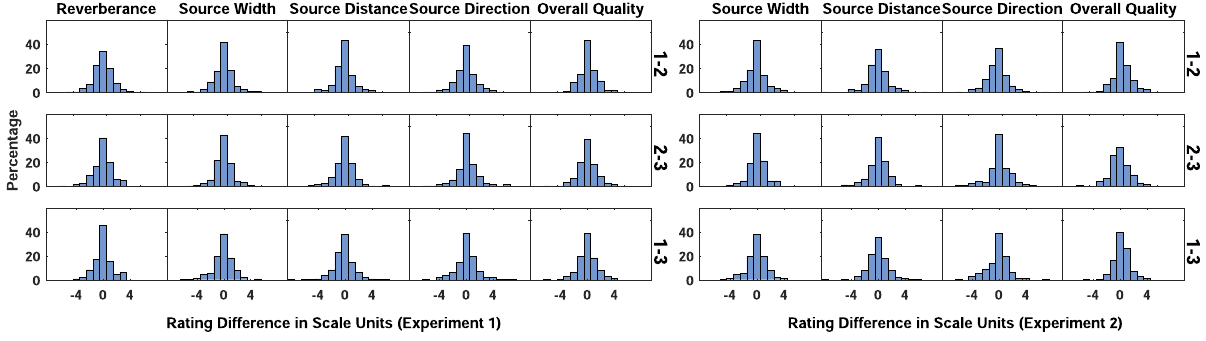
Figure 6. Histogram of rating differences between the three presentation pairs (1 – 2, 1 – 3, 2 – 3) after excluding the non-consistent ratings. Two scale units correspond to the difference between adjacent labeled scale